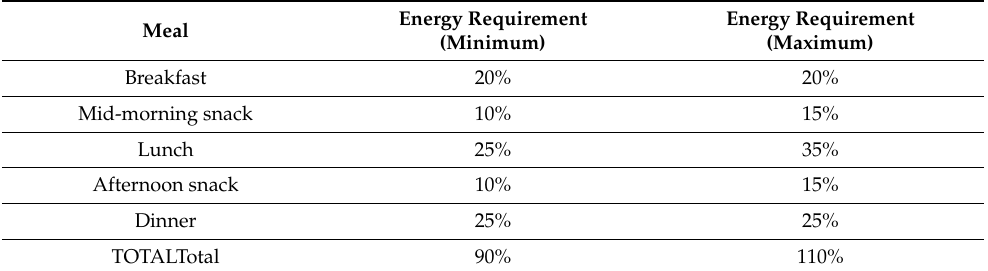
Table 1. Recommended energy (% of calories) distribution per meal for adolescents. Energy Requirement Meal (Minimum)